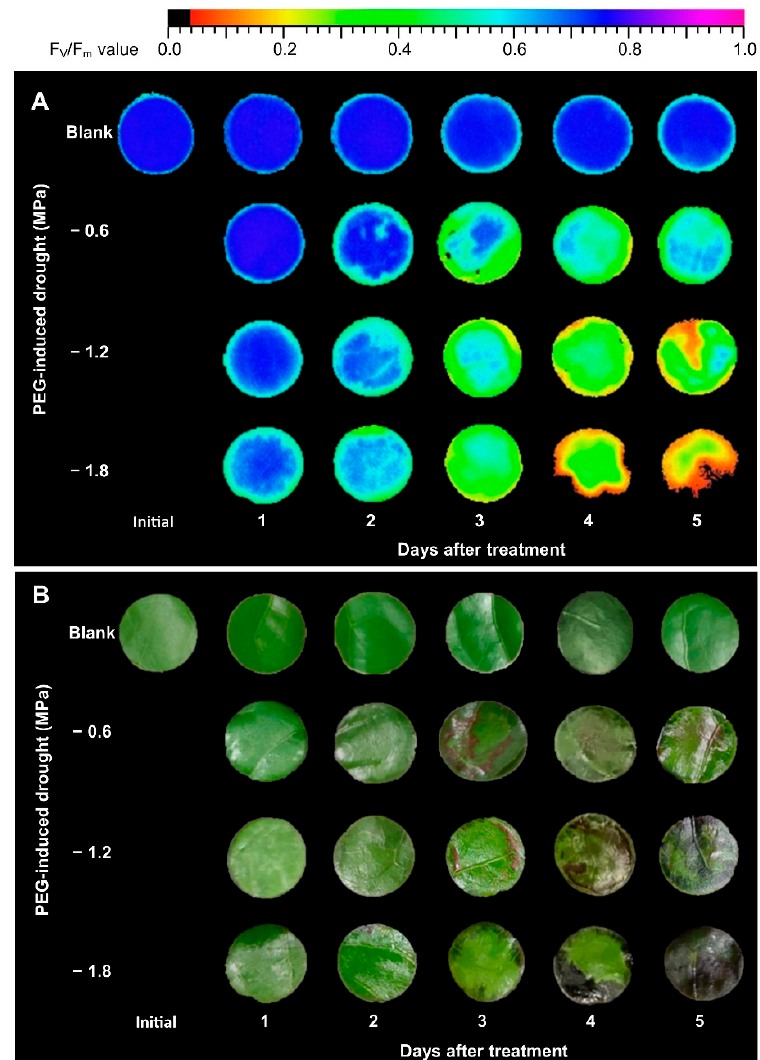
Figure 1. Chlorophyll fluorescence image ( A ) and leaf appearance correspond to F v /F m ( B ) value under PEG-induced osmotic stress during a 5-day period.